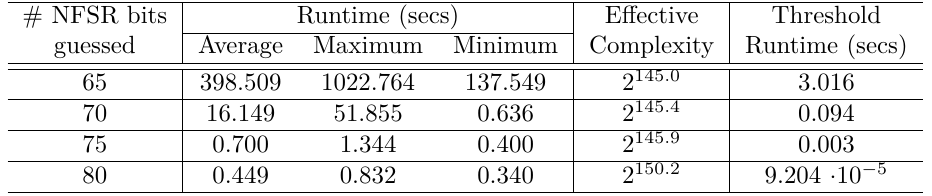
Table 2: Experimental data for algebraic attack. The Effective Complexity has been computed in terms of number of encryptions. Threshold runtime is the maximum time any equation solver can theoretically take for the total effective complexity to be below exhaustive